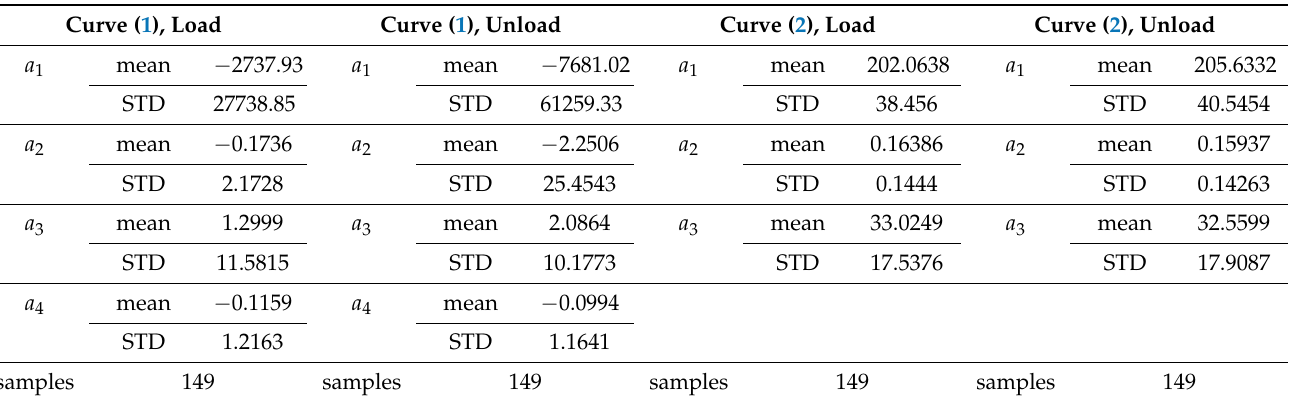
Table 2. Fitting curve coefficients